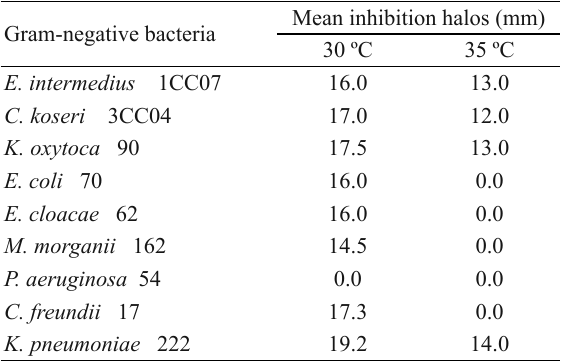
Results of the optimization of the production of active R18(6) metabolites using glucose as carbon source (incubation temperatures of 30 ºC and 35